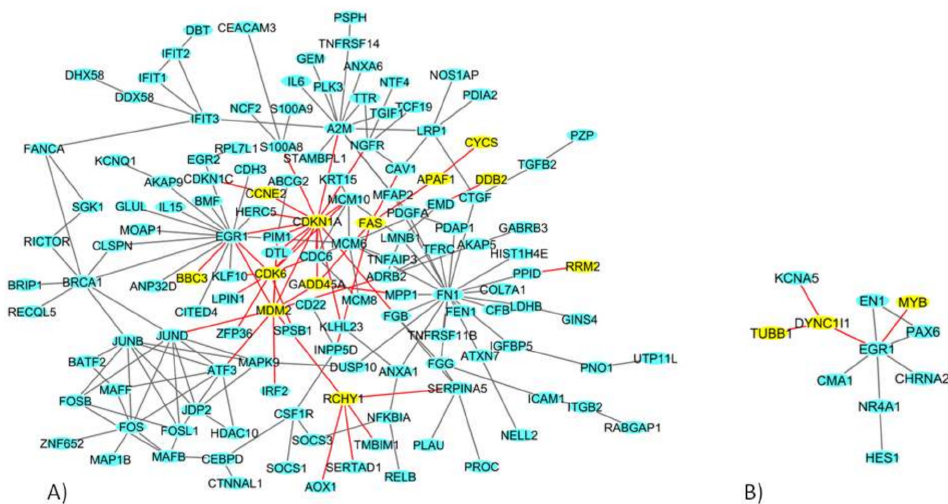
Figure 3. The deregulated densest protein-protein network (blue nodes: proteins, yellow nodes: proteins involved in crucial pathways, red edges: interactions involved yellow nodes) in ( A ) MCF7 BC and ( B ) MDA-MB-231 BC cell lines: nodes represent genes and edges represent protein interactions.